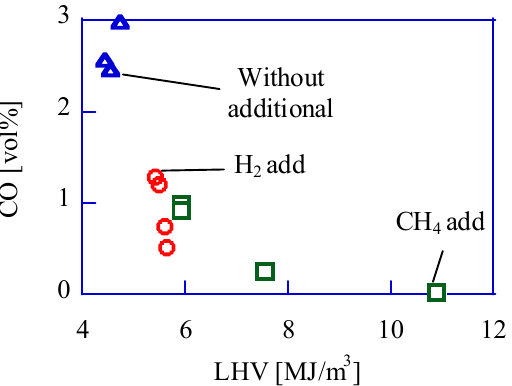
Figure 6. CO emission against LHV (experimental). Lower LHV shows larger CO density in the emission. The amount is much larger than the normal regulations in Japan.